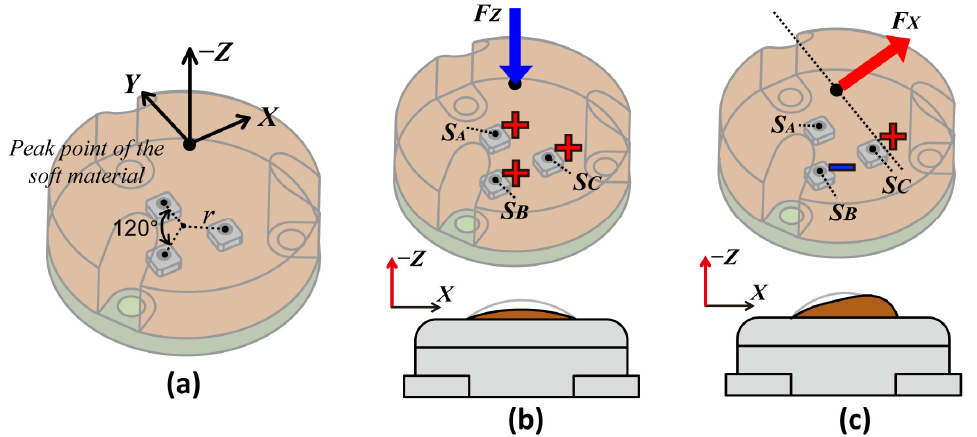
Figure 5. Schematics of measuring three-axis force with coordinate system. ( a ) Isometric view of soft material and three-phase-arranged BPSCs. ( b ) Data increasement with 𝐹 (cid:3027) and ( c ) data variance material and three-phase-arranged BPSCs. ( b ) Data increasement with F Z and ( c ) data variance with with 𝐹 (cid:3025) from three BSPCs. F X from three